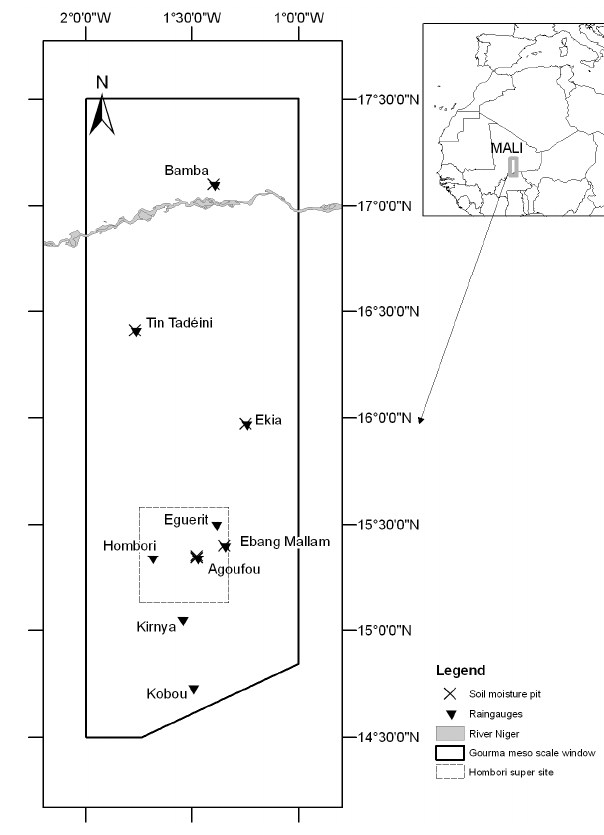
Fig. 2: The AMMA mesoscale site in Gourma (Mali) (1°W-2°W/14.5°N-17.5°N) showing the 646 Fig. 2. The AMMA mesoscale site in Gourma (Mali) (1 ◦ W– location of the soil moisture stations and automatic raingauges in 2005. 647 2 ◦ W/14.5 ◦ N–17.5 ◦ N) showing the location of the soil moisture stations and automatic raingauges in